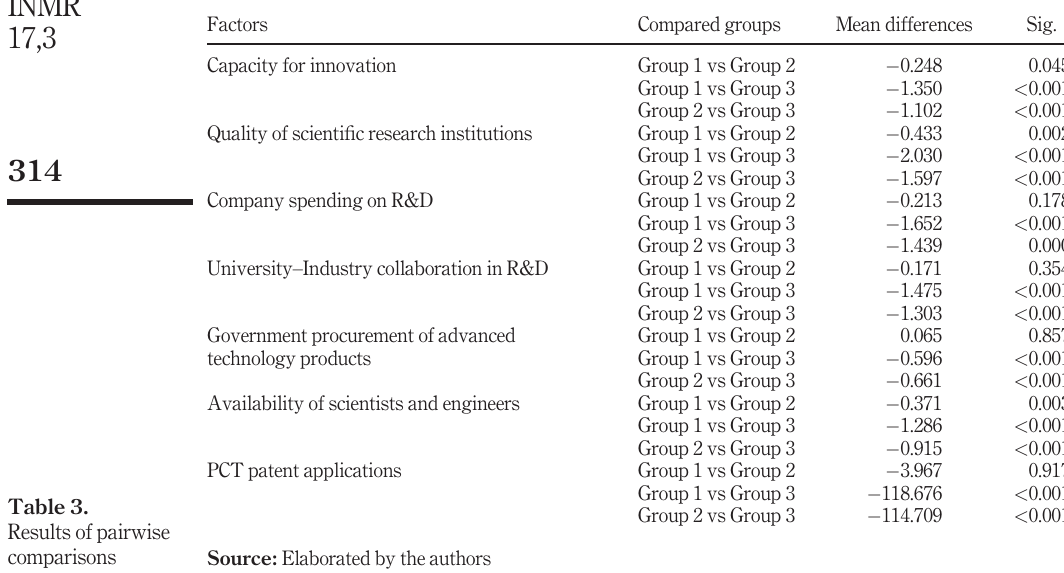
Table 3. Results of pairwise